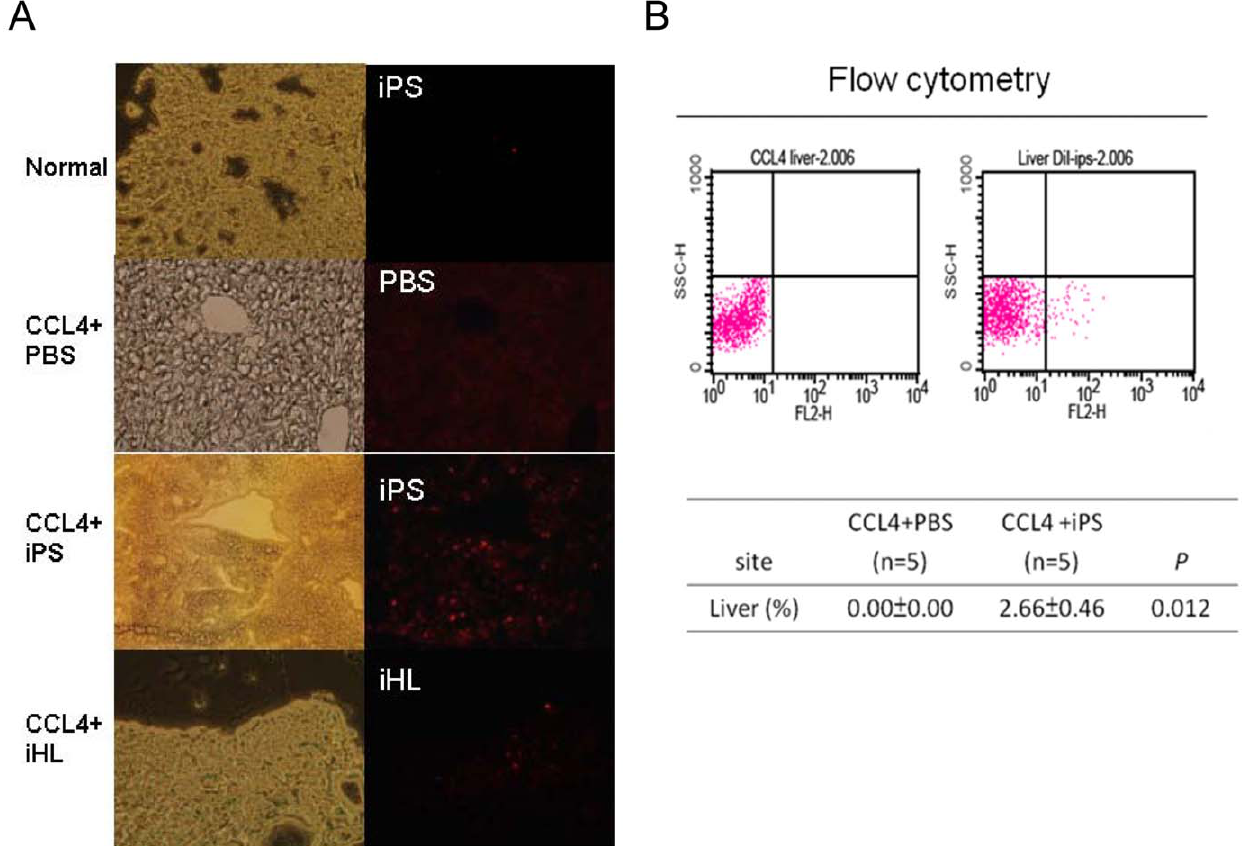
Figure 2. Localization of iPS in injured liver. The iPS and iHL were labeled with a red fluorescent dye (DiI) before use. ( A ) At 24 h post-injury, frozen sections of livers from different groups were observed. The background of Red fluorescent was present at the PBS control. The strong red fluoresence signals indicate the iPS or iHL localized in the liver. ( B ) The representative flow-cytometry diagrams showed that iPS localized in liver. Flow cytometry assay were used to calculate the percentage of iPS engrafted in the